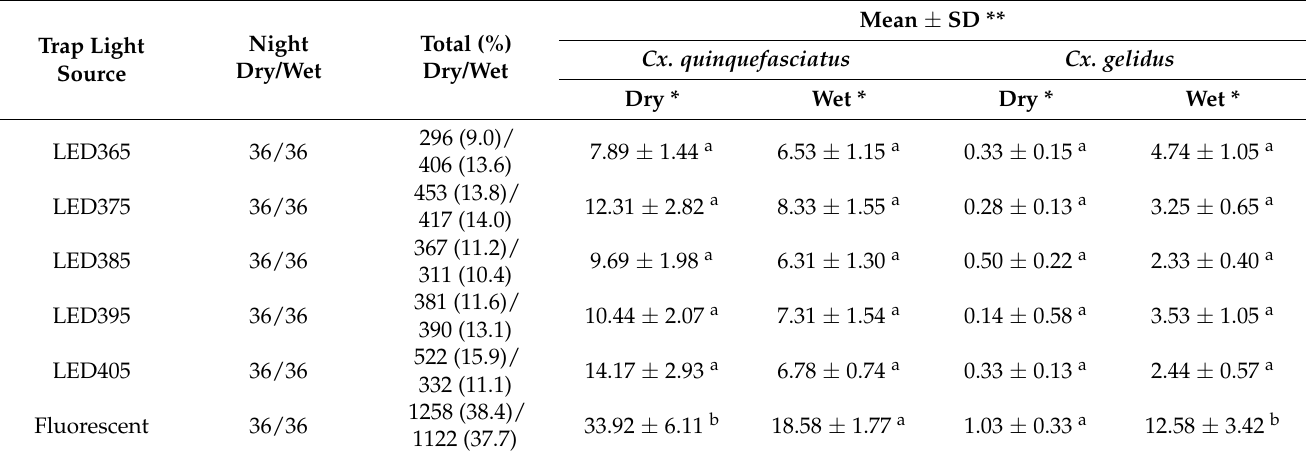
Table 3. Mean numbers of Cx. quinquefasciatus and Cx. gelidus collected during 36 trapping nights in dry and wet seasons using 6 different light source traps.